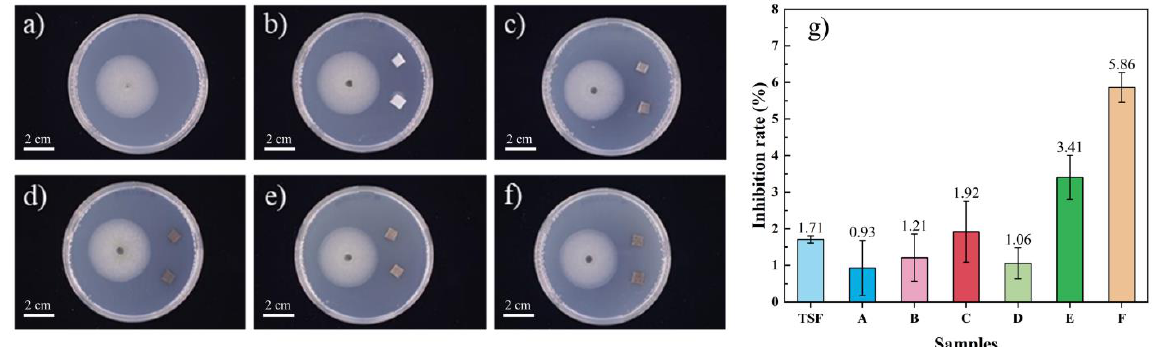
Figure 8. The influence of different samples on the colony growth of Colletotrichum micotianae Averna, ( a ) Control group; ( b ) sample A; ( c ) sample B; ( d ) sample C; ( e ) sample E; ( f ) sample F, and the ( g ) Inhibition rate of different samples to Colletotrichum micotianae Averna.